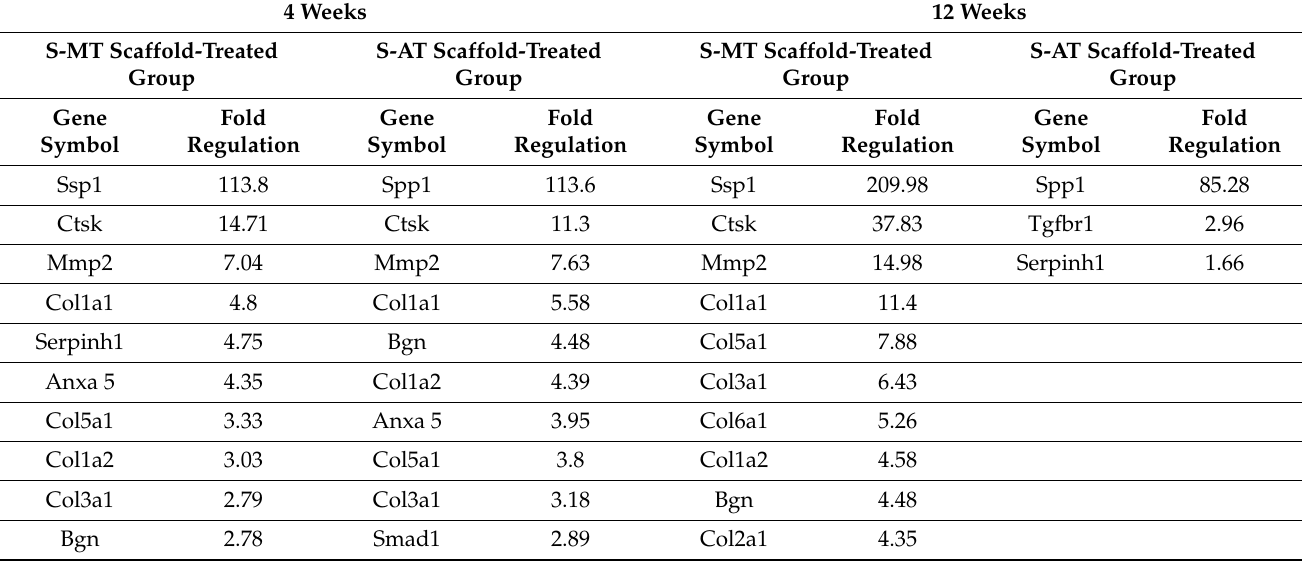
Table A1. Fold regulation of the expression of the top 10 upregulated genes for each group and time point of